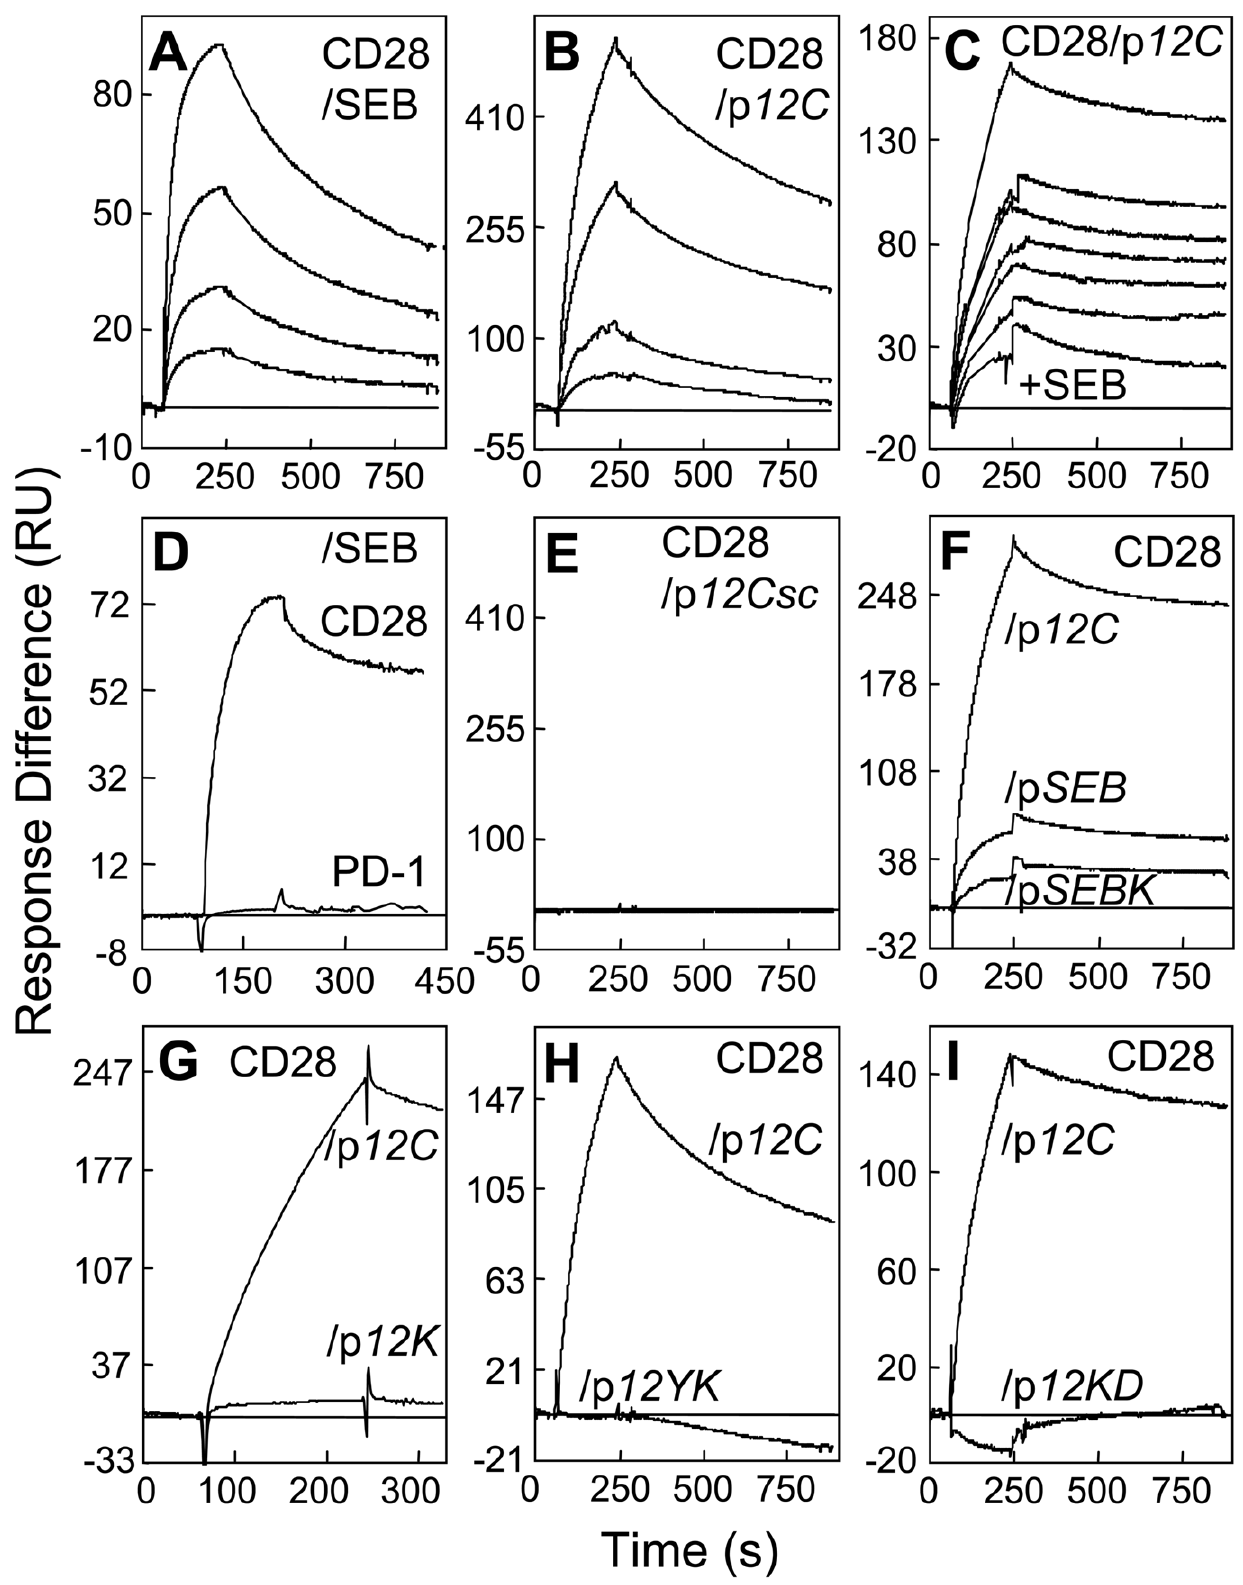
Figure 3. SEB binds CD28 through its b -strand(8)/hinge/ a -helix(4) domain. (A and B) Binding of CD28-Fc in 2-fold increments from 0.25 m M to immobilized SEB (A) and from 0.125 m M to p 12C (B). (C) Binding of CD28-Fc (2 m M) to p 12C without SEB (top curve) or with SEB in 2-fold increments from 0.78 m M (6 lower curves, top to bottom). (D) Binding of 2 m M PD1-Fc and CD28-Fc to immobilized SEB. (E) Binding of CD28-Fc in 2-fold